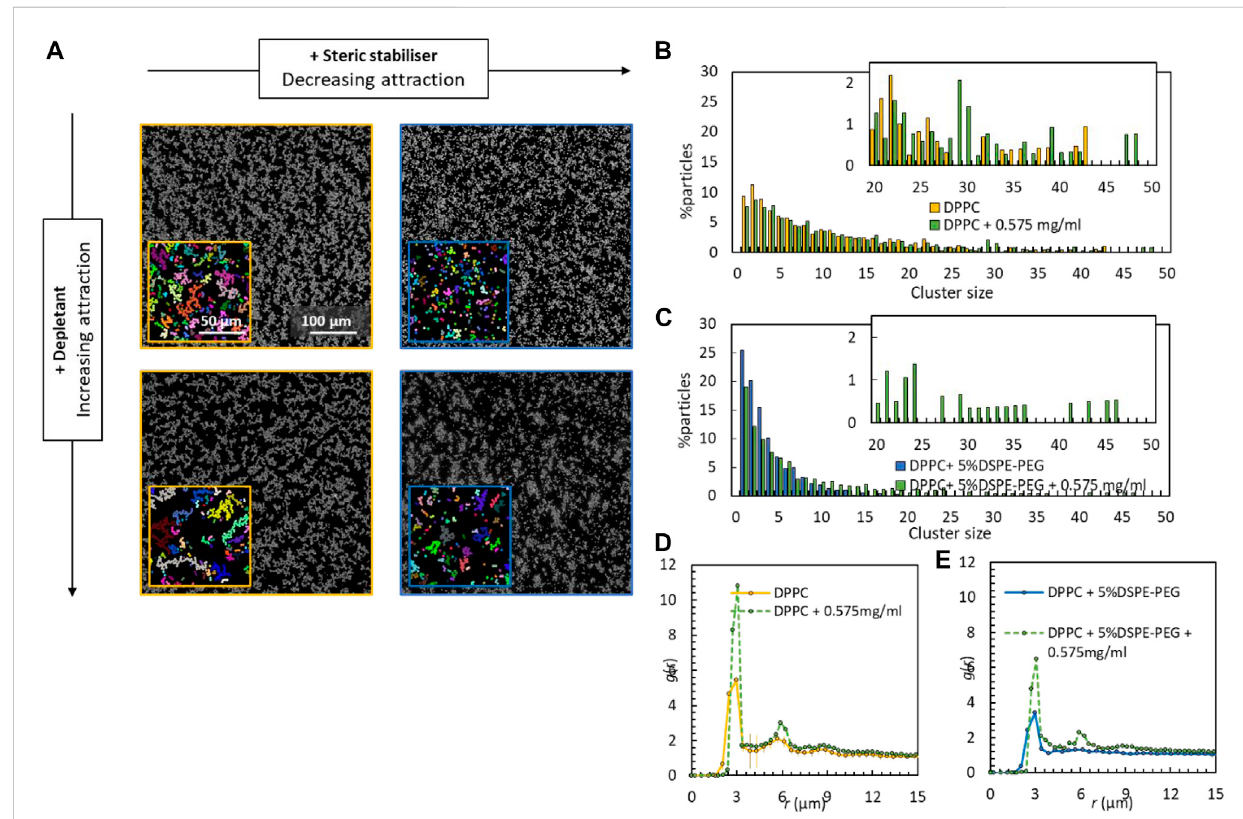
FIGURE 5 (A) DPPC CSLBs at φ = 0.11 under a range of conditions to visually demonstrate the tuneability of interaction. (top left panel) DPPC CSLBs, (top right panel) DPPC+5%DSPE-PEG 2000 CSLBs, (bottom left panel) DPPC CSLBs with 100 kDa PEG depletant at 0.05 c *, (bottom right panel) DPPC+5%DSPE- PEG 2000 CSLBs with 100 kDaPEG depletant 0.05c*.The insets displaytheassignmentofindividualCSLBs to differentclusters, eachofwhichisrandomly colouredusingMatlab. (B – C) DistributionofCSLBsathighareafraction φ =0.11inclustersizesupto50withandwithout100 kDaPEGdepletantfor (B) DPPC CSLBs and (C) DPPC+5%DSPE-PEG 2000 CSLBs. Insets show in more detail the distribution of particles in cluster sizes from 20 to 50 CSLBs/ cluster. (D – E) g ( r ) curves comparing the strength of interaction at high area fraction φ = 0.11 between (D) DPPC CSLBs and (E) DPPC+5%DSPE-PEG 2000 CSLBs with and without 0.05 c *100 kDa PEG (green dashed